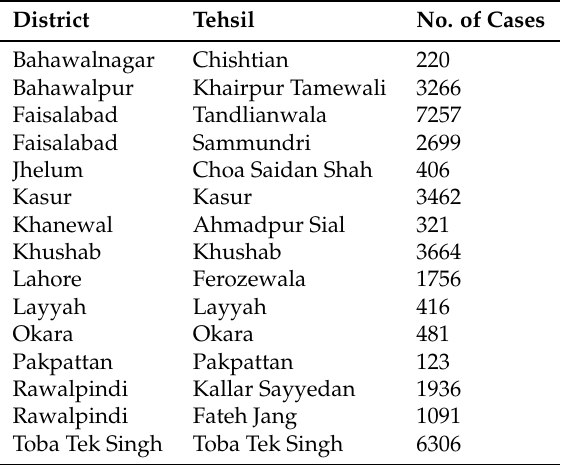
Figure 4. Cholera incidence data distribution in the 15 clusters. Table 2. The 15 hotspots identified with their corresponding tehsil and district as well as the number of cases within each hotspot